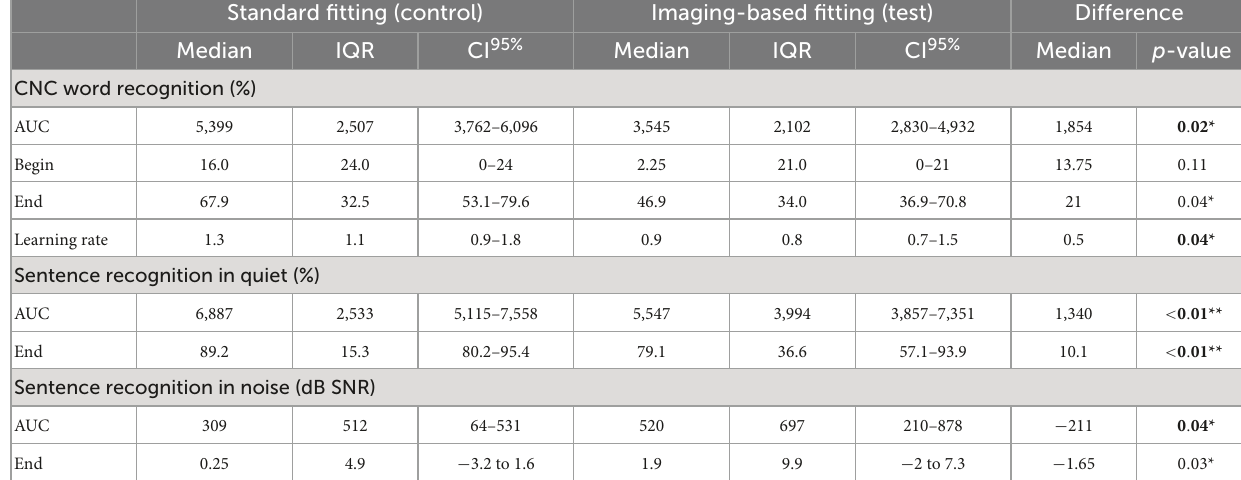
TABLE 3 Word and sentence recognition analyzed by ITT for variables AUC (area under the curve), Begin (first fit), and End (after randomization period). Standard fitting (control)